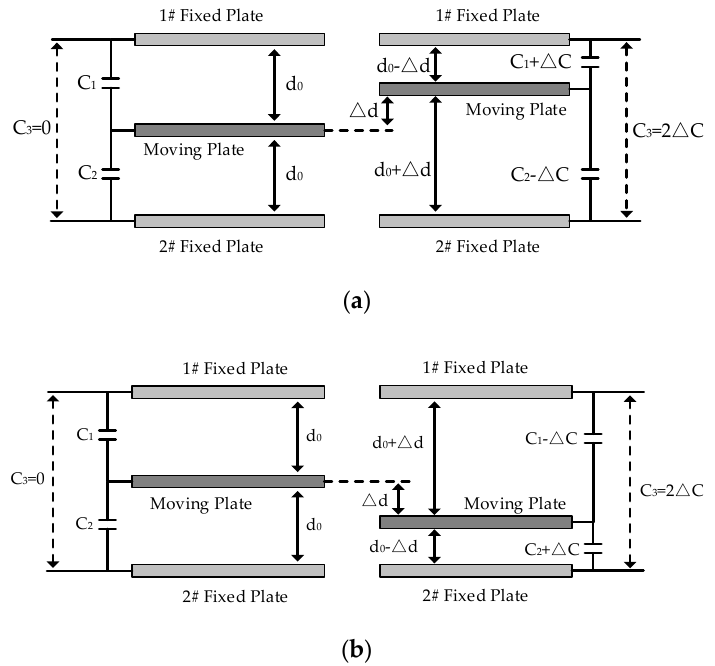
Figure 1. Functional schematic diagram of MEMS-gyros. ( a ) hardware design; ( b ) system schematic. k and k are stiffness coefficients of springs in driving direction x -axis and sensing Where x y direction y -axis, and are damping coefficients in x -axis and y -axis. With the help of the driving circuit, the mass m vibrates along x -axis under sinusoidal voltage with frequency MEMS-gyros rotate along z -axis at angular velocity Ω , Coriolis force causes an displacement along y -axis. Technically, combs of sensing circuit can be abstracted as plate capacitors composed of moving plates and fixed plates. Any carrier’s angular velocity is obtained by measuring the capacitance variation in y -axis. Figure 2 shows the state diagram of combs before and after clockwise or counter clockwise rotation.